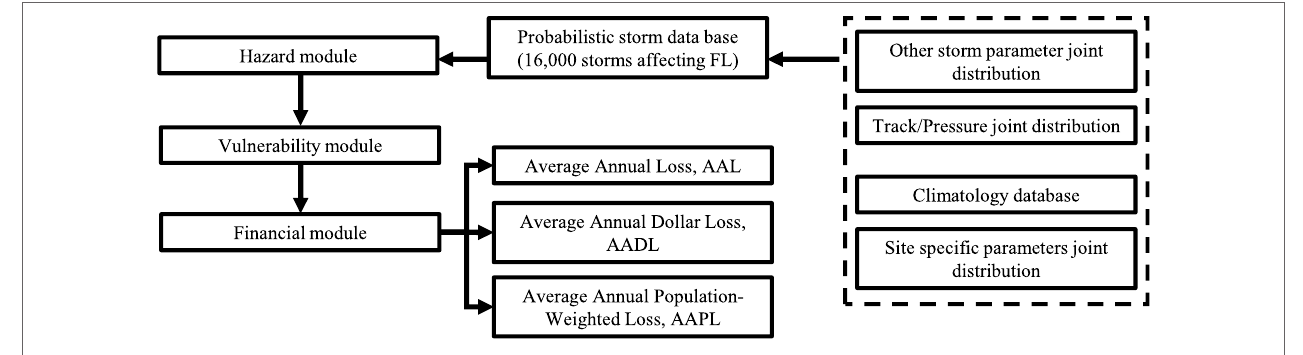
FigUre 2 | The methodology for regional loss estimation.